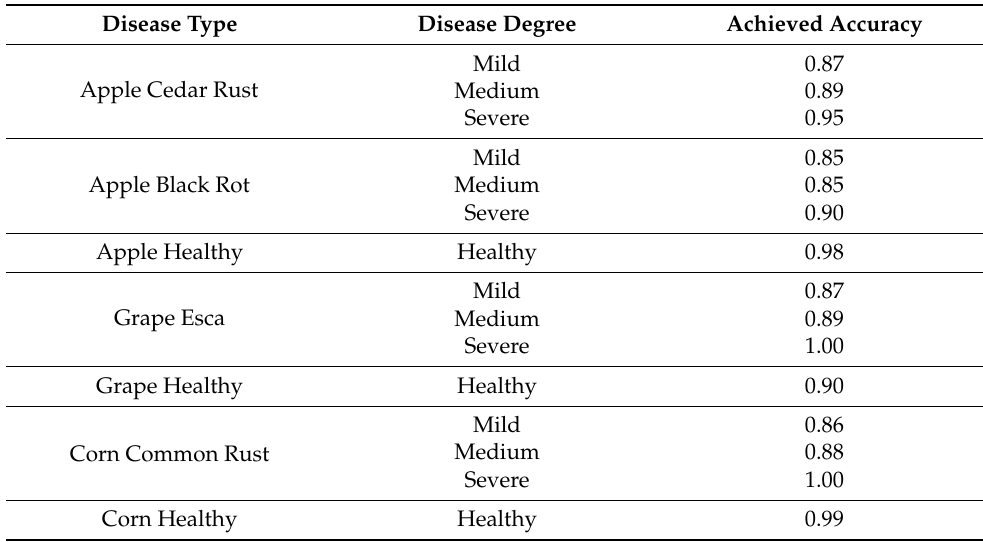
Table 9. Accuracy of Disease